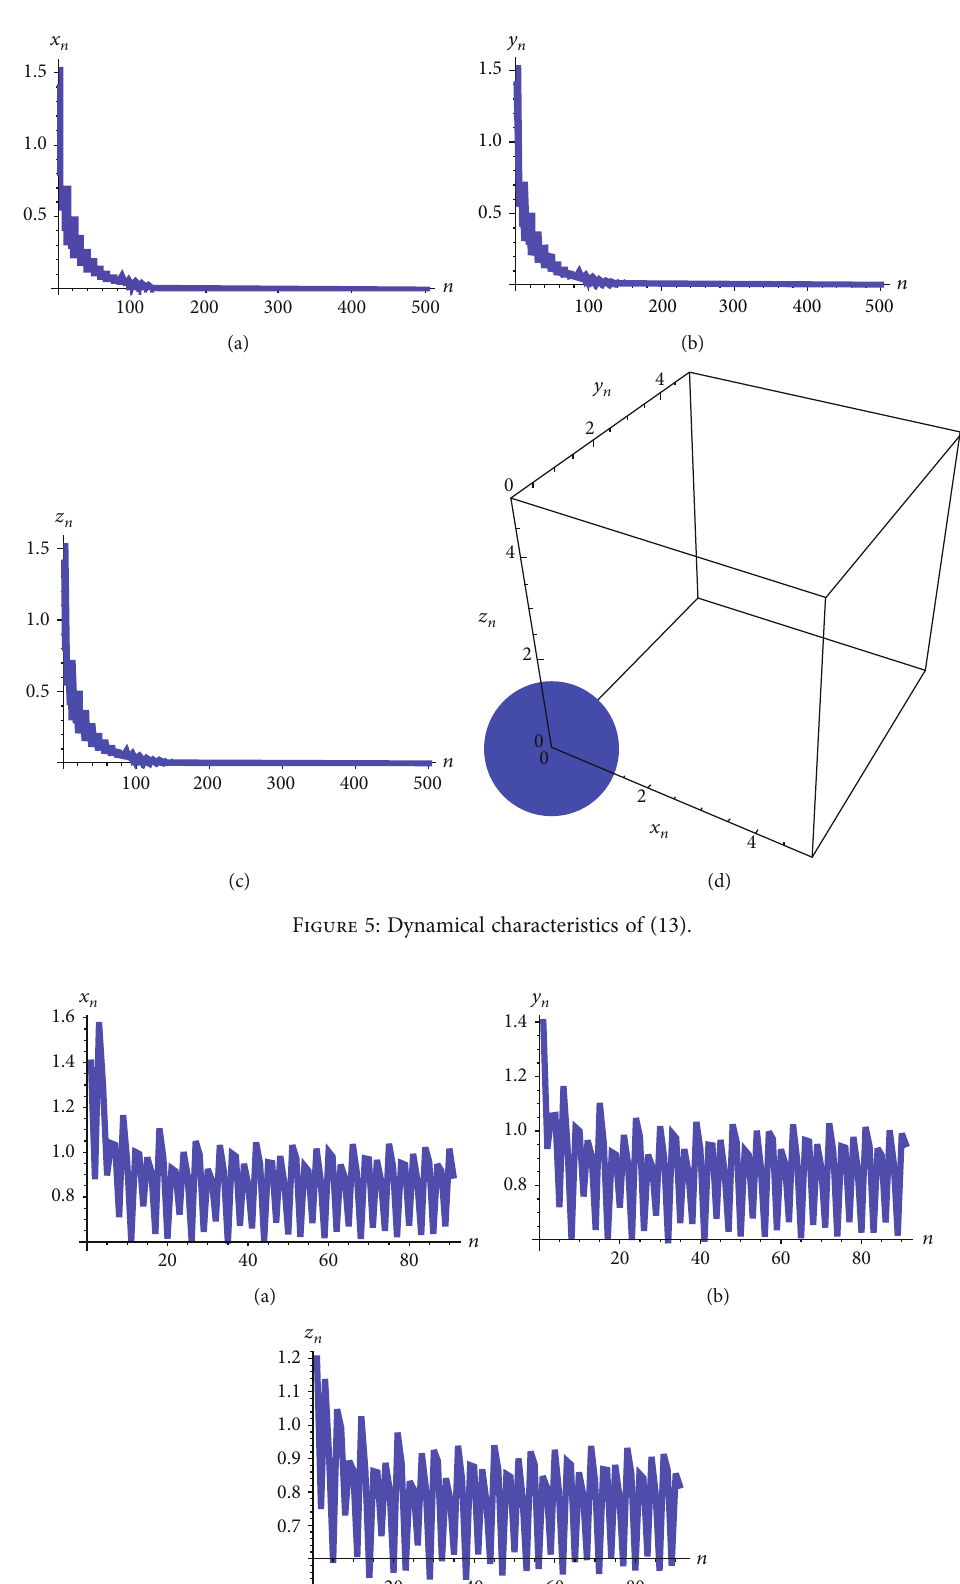
Figure 6: Dynamical characteristics of